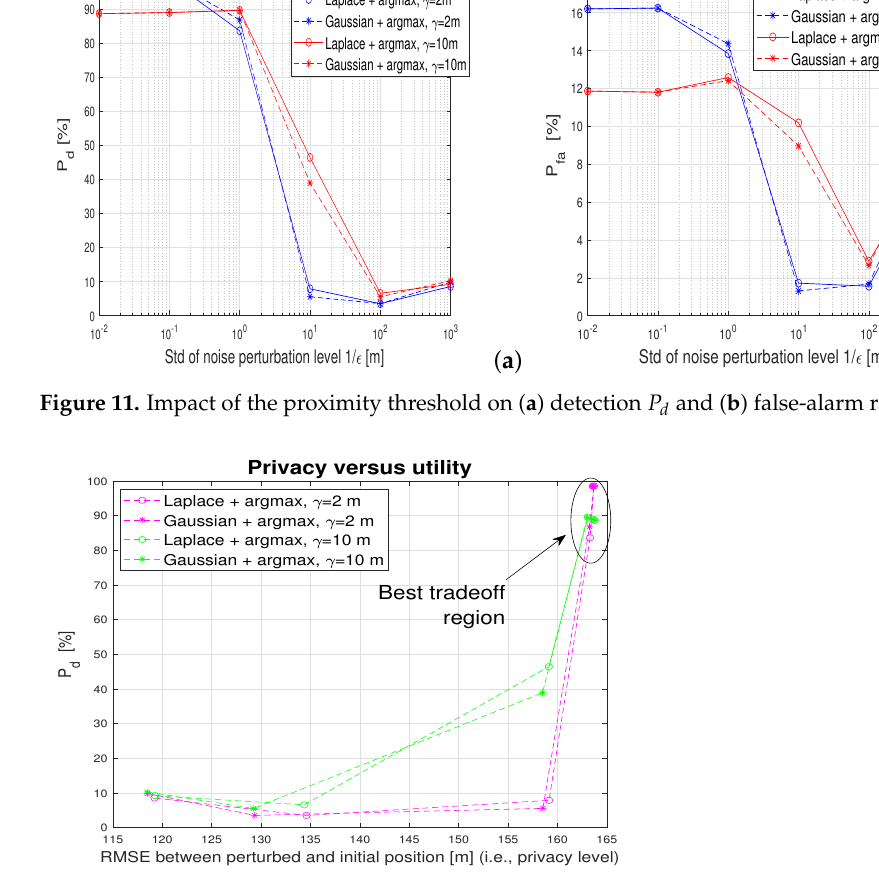
Figure 12. Privacy versus utility tradeoff. Argmax metric. Proximity thresholds γ = 2 m and γ = 10 m.